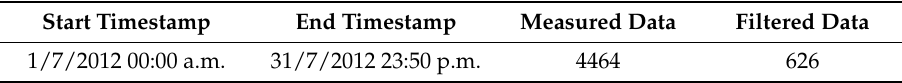
Table 1. SCADA dataset